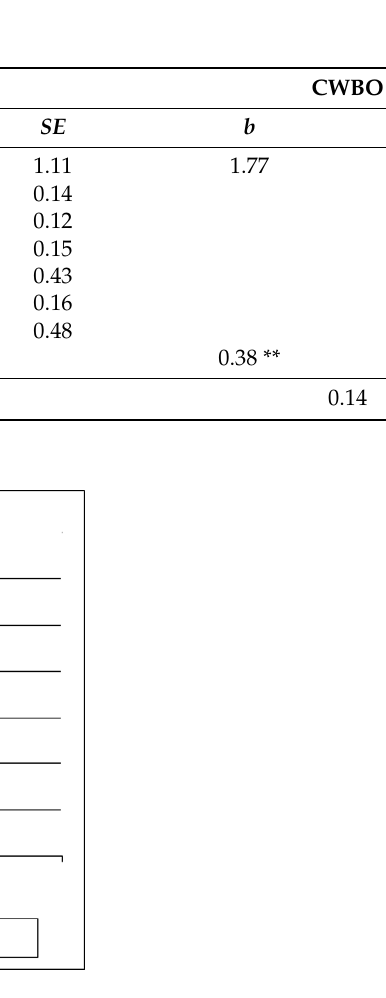
Figure 3. Moderation Test.